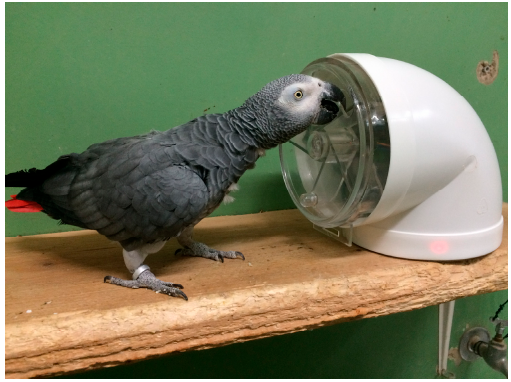
Figure 7. metamusic , disc jockey (DJ) device [7].